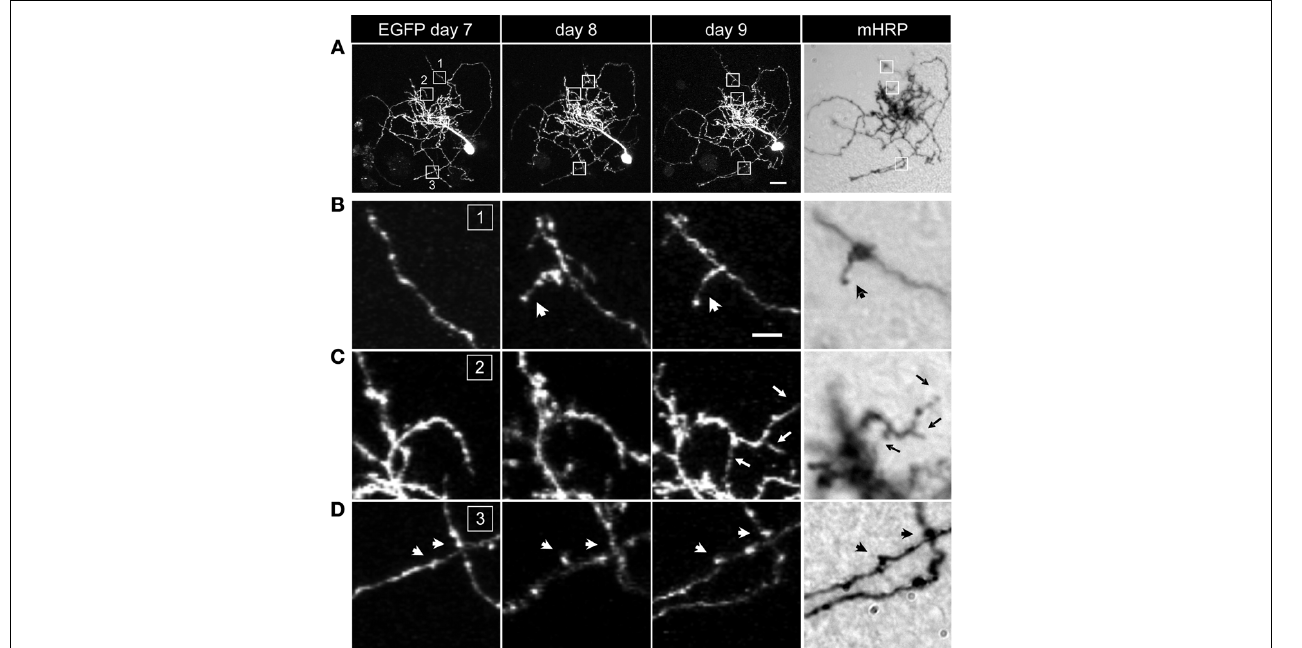
FIGURE 2 | mHRP and EGFP are detected throughout the fi ne structure of transfected neurons. (A) Two-photon images of a neuron expressing both EGFP and mHRP were collected once a day over 9 days. The right column shows the same mHRP-labeled neuron revealed by DAB reaction. (B–D) High